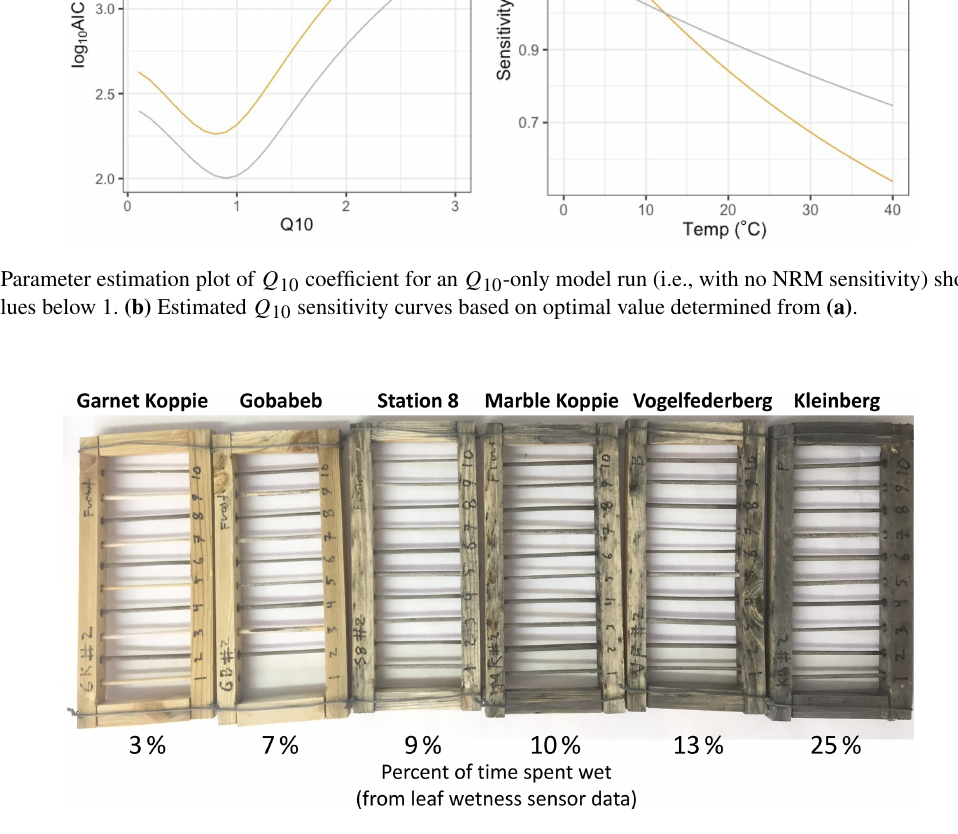
Figure A7. Photos of litter racks from each site (from driest on the left to wettest on the right) after 18 months in the field. The dark color on the racks from the wetter sites is from dark-pigmented fungal growth on both the tillers and the wooden frames after exposure to frequent NRM events.